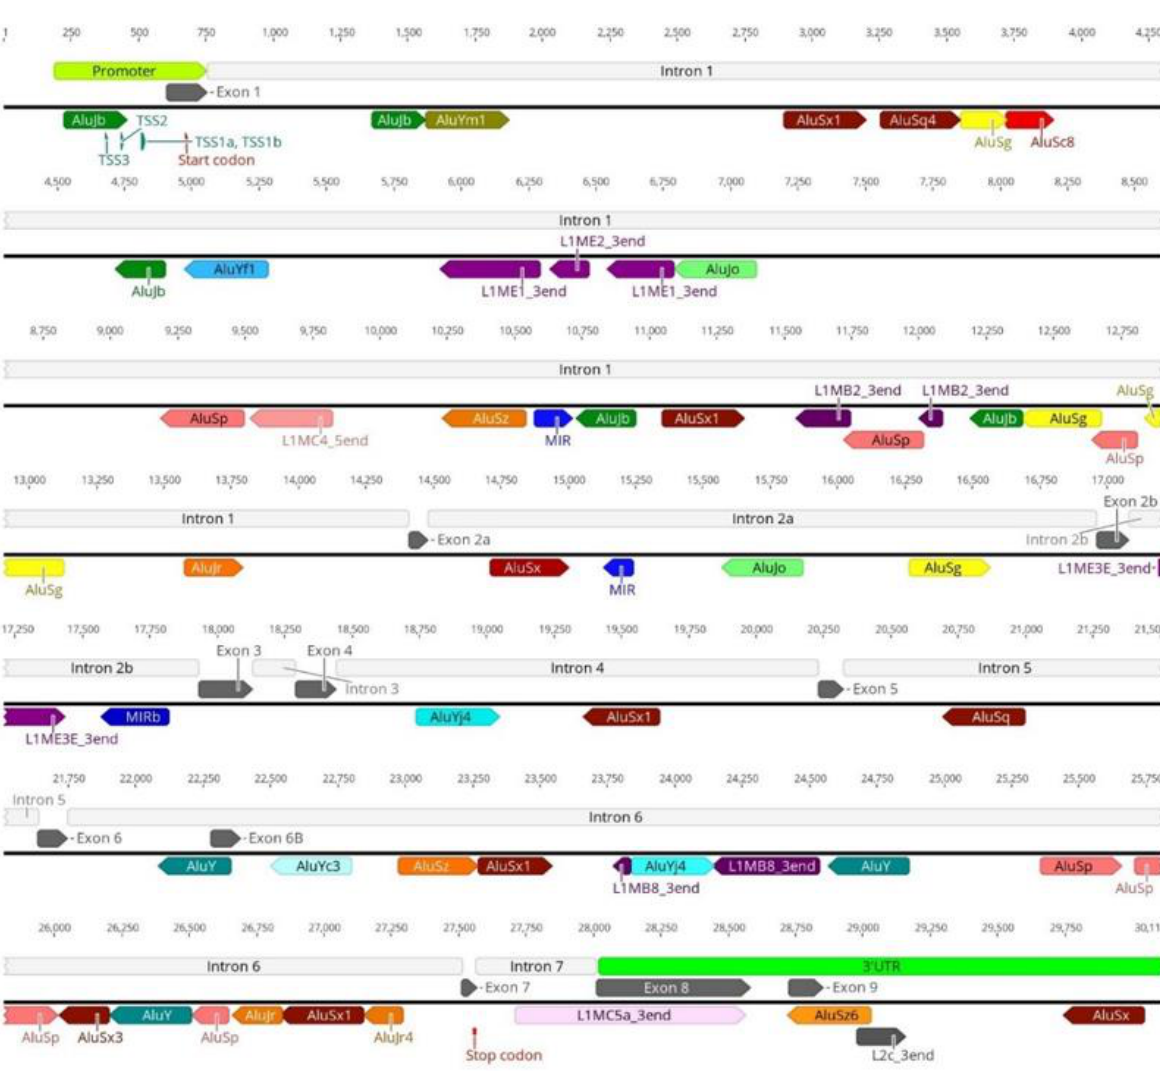
Figure 5. Identification of TEs within the SMN1 Consensus Coding Sequences (CCDSs). SMN1 longest isoform CCDS represented in grey on top has a L1MC5a element (represented by a pink arrow) inserted in its sequence responsible for the extension of the CCDS. Contrarily, SMN1 most common CCDS, isoform (d; represented as a blue bar), is shorter and does not have any TE insertion in its sequence. Both sequences show 100% sequence identity within the overlapped region. We also observed the presence of a L1MC5a element within the longest CCDS for SMN2 .